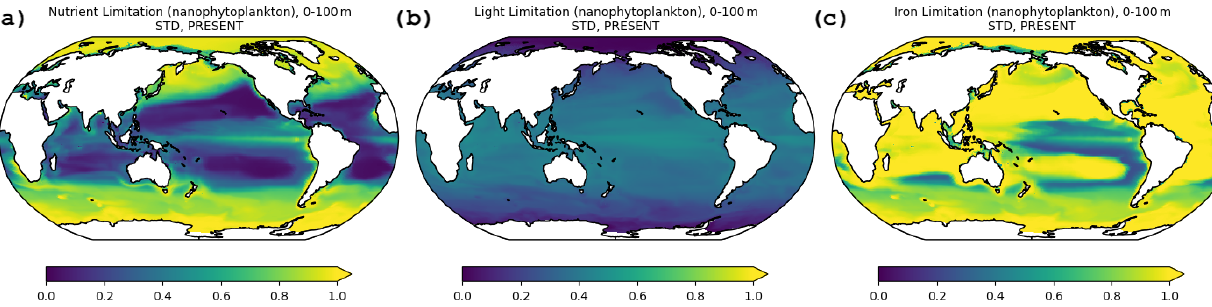
Figure 4. Limitation for nanophytoplankton production by nutrients (N and P; a ), light (b) , and iron (c) . Low values indicate high limitation imposed by the respective property.